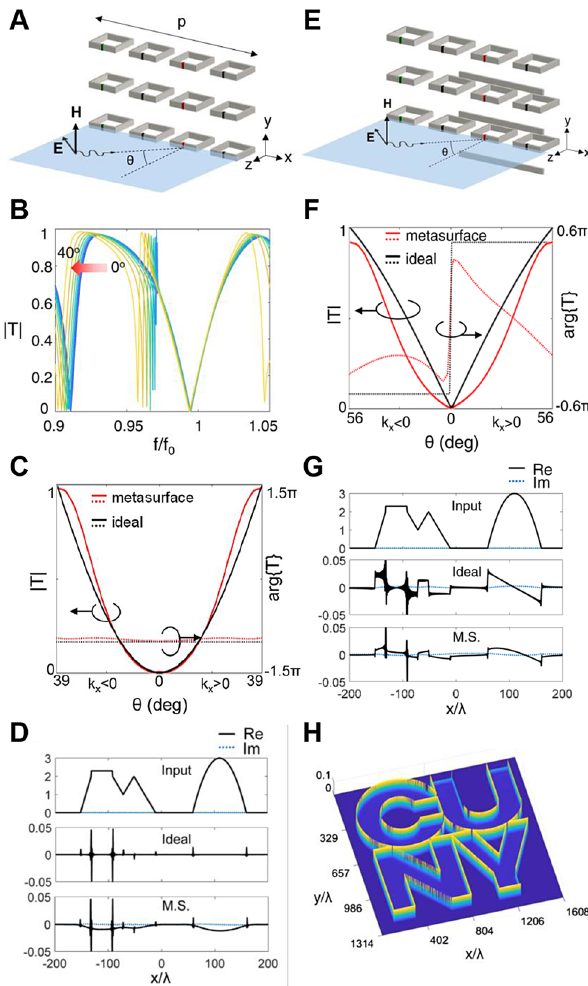
Figure 11: Nonlocal metasurface. (A) The structure of a metasurface consisting of an array of split-ring resonators (SSRs) under TM illumination [50]. (B) The spectrum of the transmission response of the metasurface when SSRs are periodically modulated. (C) The optical transfer function (OTF) if the metasurface fi tted to a second-order differentiator. (D) Output of an ideal second-order differentiator and of the metasurface from the input signal shown in the top panel. (E) Broken-symmetry metasurface enabling an asymmetric response with respect to positive and negative k x to realize fi rst-order differentiation. (F) The transmission pro fi le as a function of the incidence angle for a symmetry-broken metasurface enabling fi rst-derivative operation. (G) Output of an ideal fi rst-order differentiator working as an edge detector. (H) Detected edges of the CUNY logo for illumination with unpolarized light from the normal direction